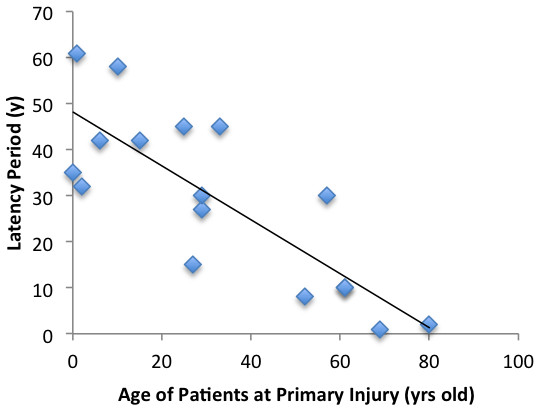
Relationship between the age of patients at initial injury and the length of the latency period.